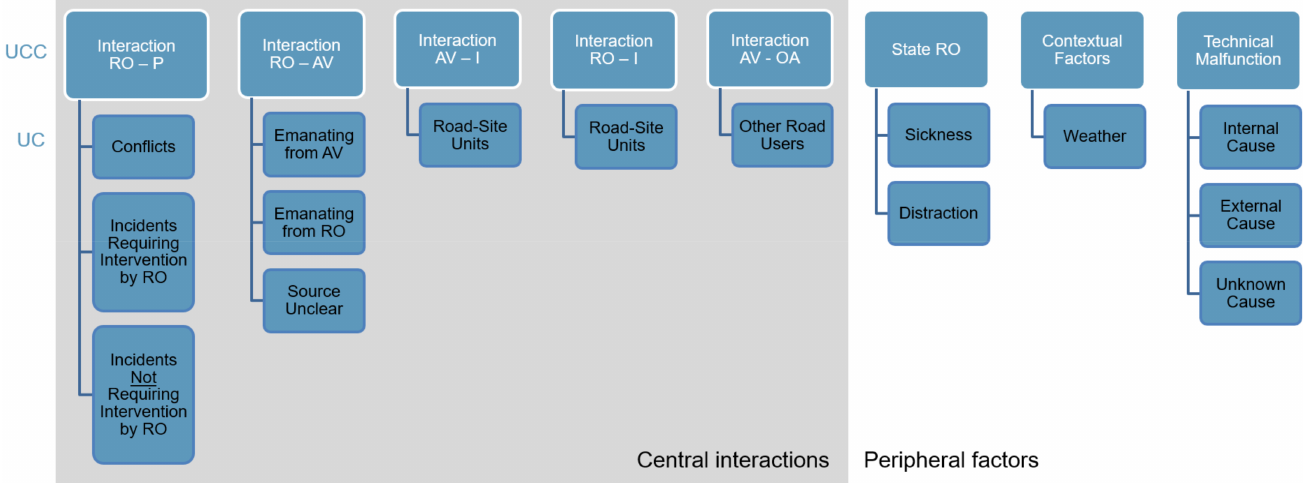
Figure 9. Structure of use case clusters (UCCs, top row) and use cases (UCs, rows below top row). The core of the scenario collection is made up of interactions between different actors (central inter- actions). In addition, UCCs regarding the remote operator’s state, contextual factors, and technical malfunctions related to peripheral factors that are not directly based on interactions. RO = Remote Operator, AV = Highly Automated Vehicle, P = Passengers, I = Infrastructure, OA = Other